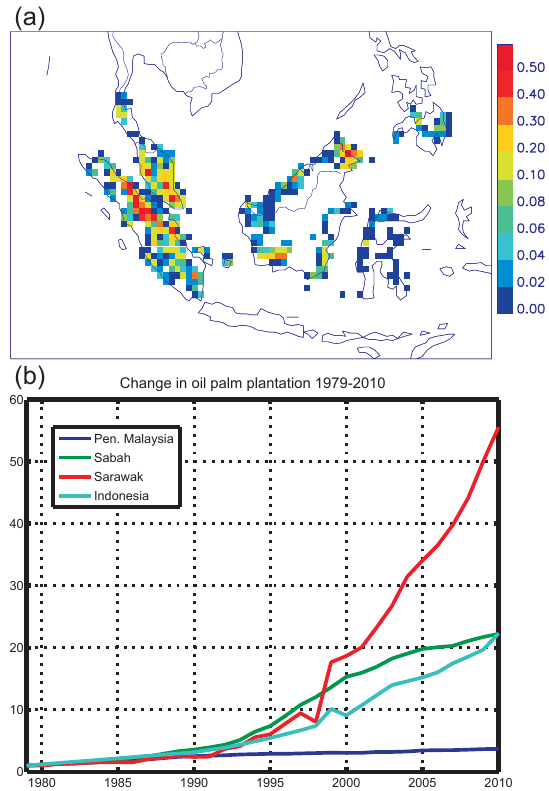
Fig. 2. (a) Spatial distribution of the fraction of oil palm plantations in 2010 (Koh et al., 2011; Miettinen et al., 2012a) gridded onto 0.5 ◦ resolution. (b) Evolution of oil palm plantation area in Indonesia and Malaysia (Peninsular Malaysia, Sabah, and Sarawak) between 1979 and 2010, normalized to the 1979 value. Source: Miettinen et al. (2012b) for Indonesia, http://bepi.mpob.gov.my for